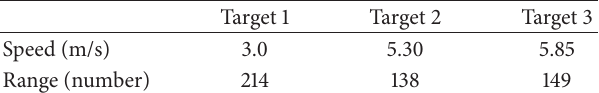
Table 1: Target position (GMTI